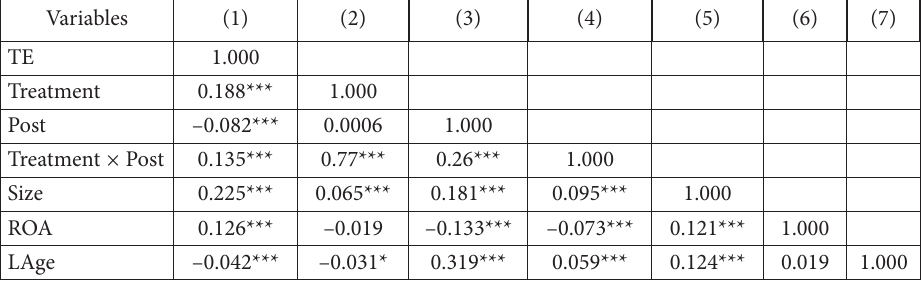
Table 4. Correlation matrix – PSM sample (source: author’s